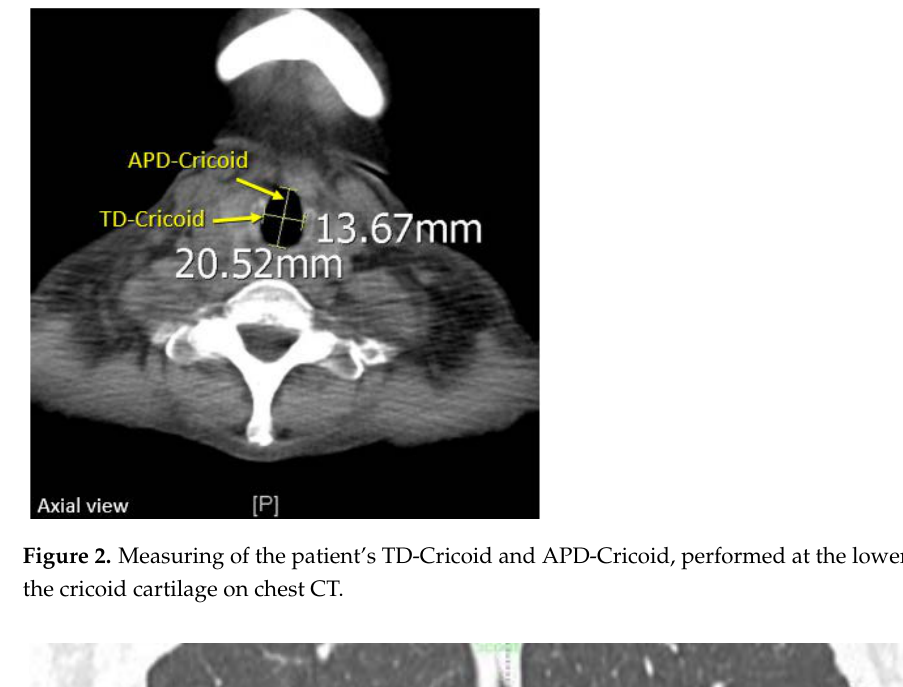
Figure 2. Measuring of the patient’s TD-Cricoid and APD-Cricoid, performed at the lower border of the cricoid cartilage on chest CT.